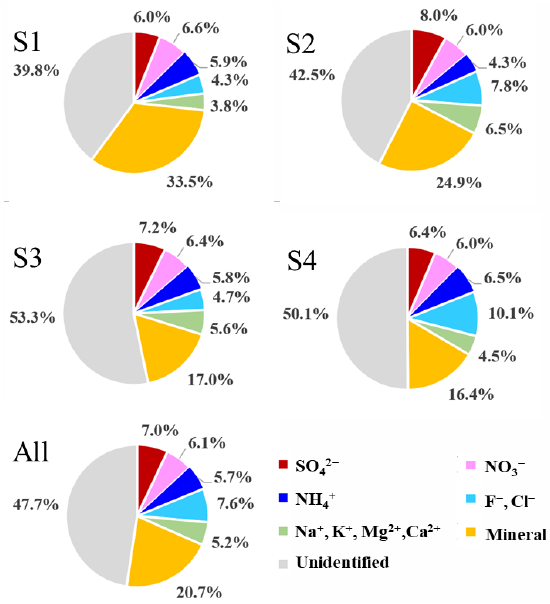
Figure 6. Pie-chart showing the chemical compositions (in %) of PM 2.5 mass concentrations for the sampling sites.